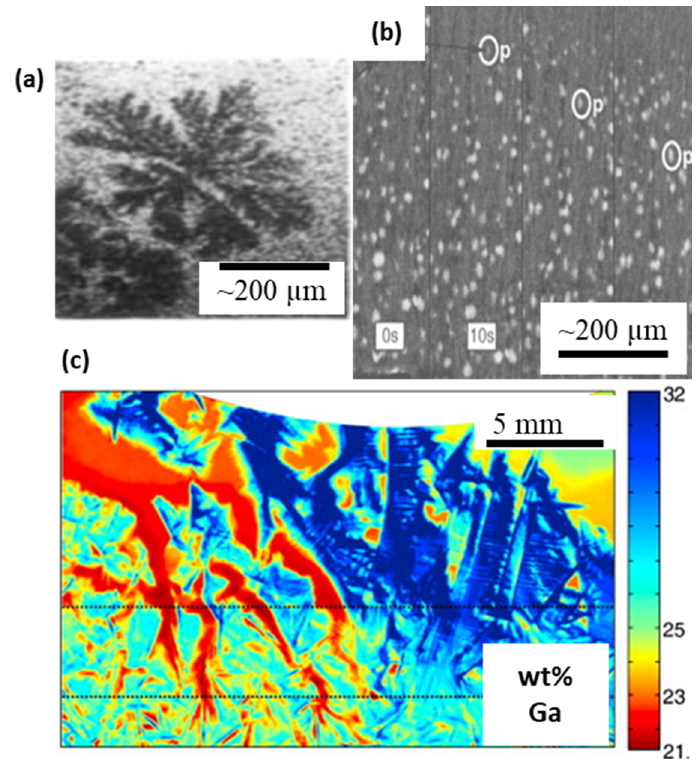
Figure 3. In situ radiography experiments in laboratory X-ray sources, ( a ) equiaxed dendritic solidification of Al-30wt%Cu alloy (after Miller and Beech [16]). ( b ) evolution of microstructures and hydrogen porosity during solidification of Al-Cu alloy (after Lee and Hunt [77]). ( c ) Real-time observations of freckle formation in Ga-In alloys, (after Boden et al. [87]). Permitted for reuse from respective publishers.